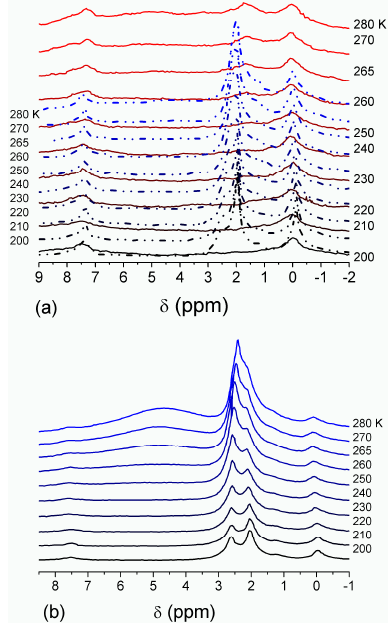
Figure 4. 1 H NMR spectra, of water adsorbed by gelatin gel recorded at different temperatures: ( a ) initial freeze-dried (0.3 wt % H 2 O) in CDCl 3 (solid lines) and in a mixture CDCCl 3 :CD 3 CN 3:1 at ( a , dashed-dotted lines) 0.8 wt % and ( b ) 10 wt % of water. Signal at 0 ppm corresponds to tetramethylsilane added as a standard; signal at 7.2 ppm corresponds to residual CHCl 3 (reproduced from Ref. [47] with permission from The Royal Society of Chemistry).